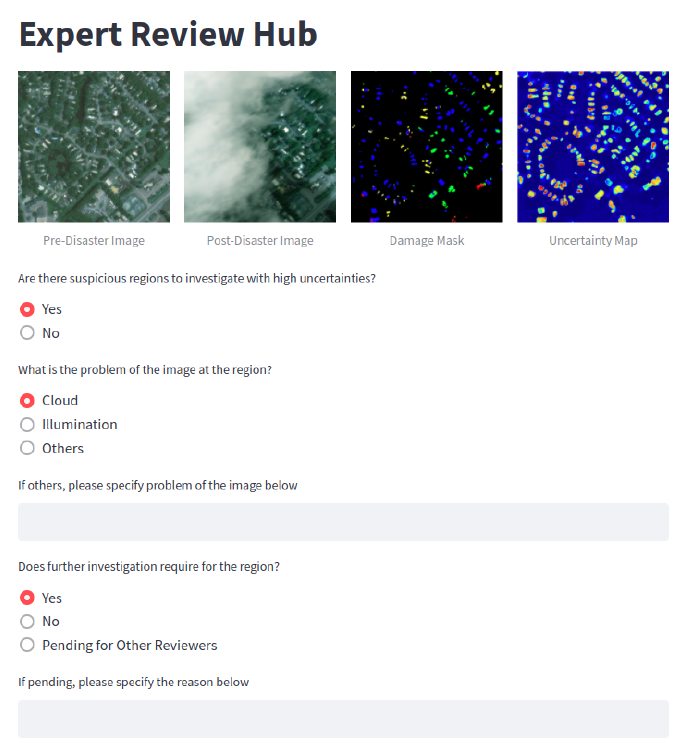
Figure 6. The illustration of website interface for expert